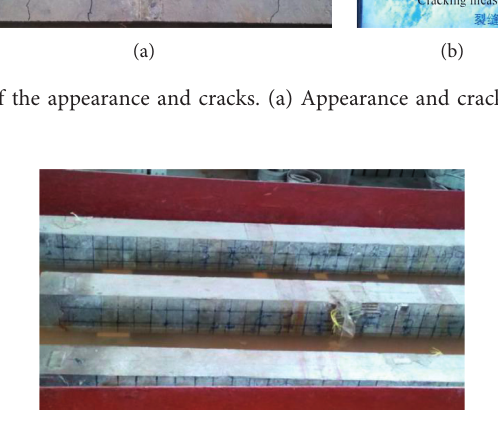
Figure 5: Schematic of the corrosion test